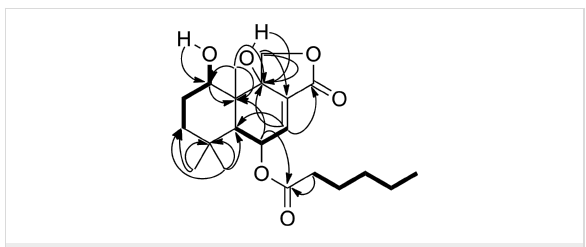
spectra (Figure 2).